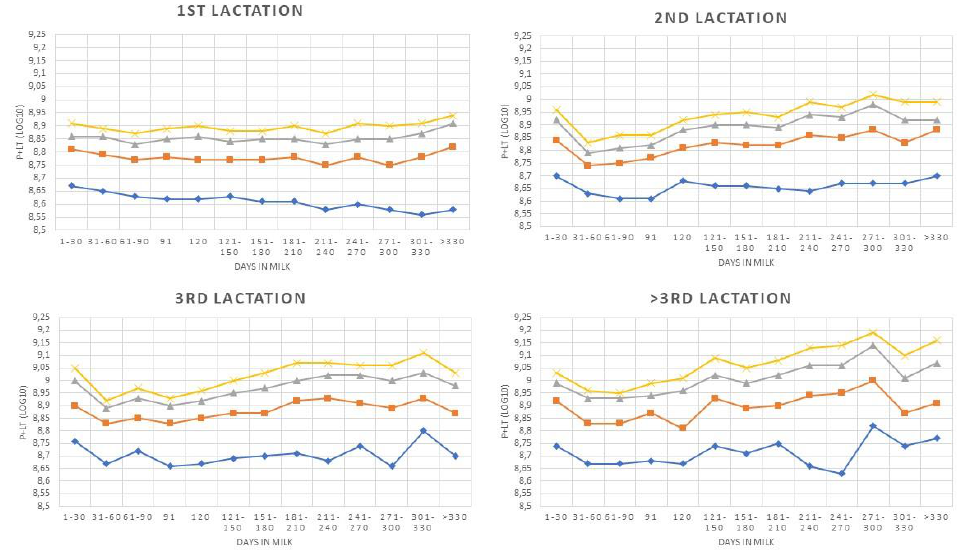
Figure 1. Differential Somatic Cell Count patterns during lactation classified by parity and Somatic Cell Count level ( ≤50,000 cells/mL; ≤100,000 cells/m; ≤150,000 cells/m; ≤200,000 cells/m).